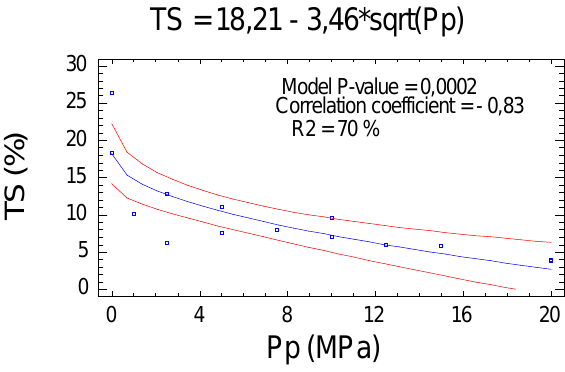
Figure 6. Influence of Pp on the thickness swelling (TS).